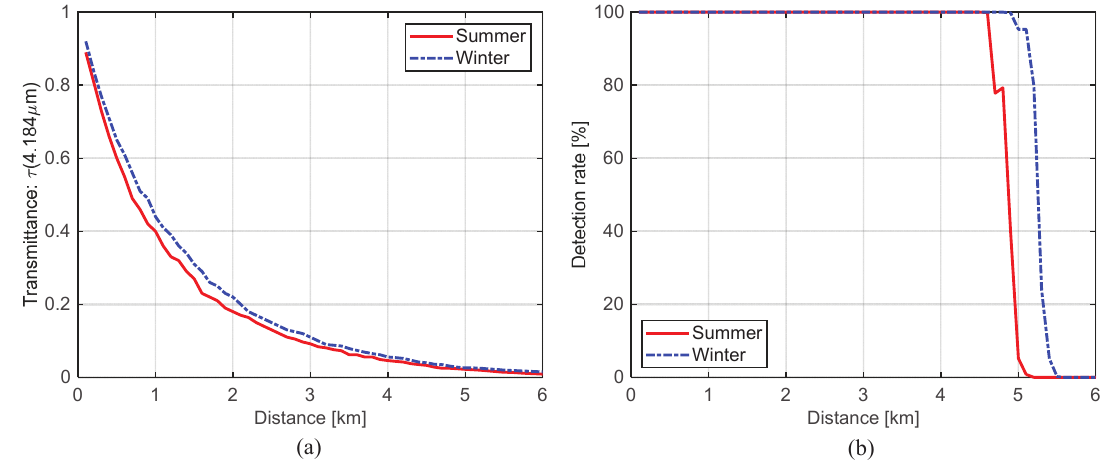
Figure 20. ( a ) Atmospheric transmittance vs. distance, ( b ) Monte Carlo simulation-based detection